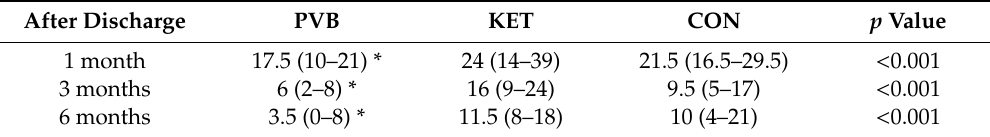
Table 3. The severity of post-thoracotomy pain syndrome detected with NPSI (0–10) as medians (interquartile